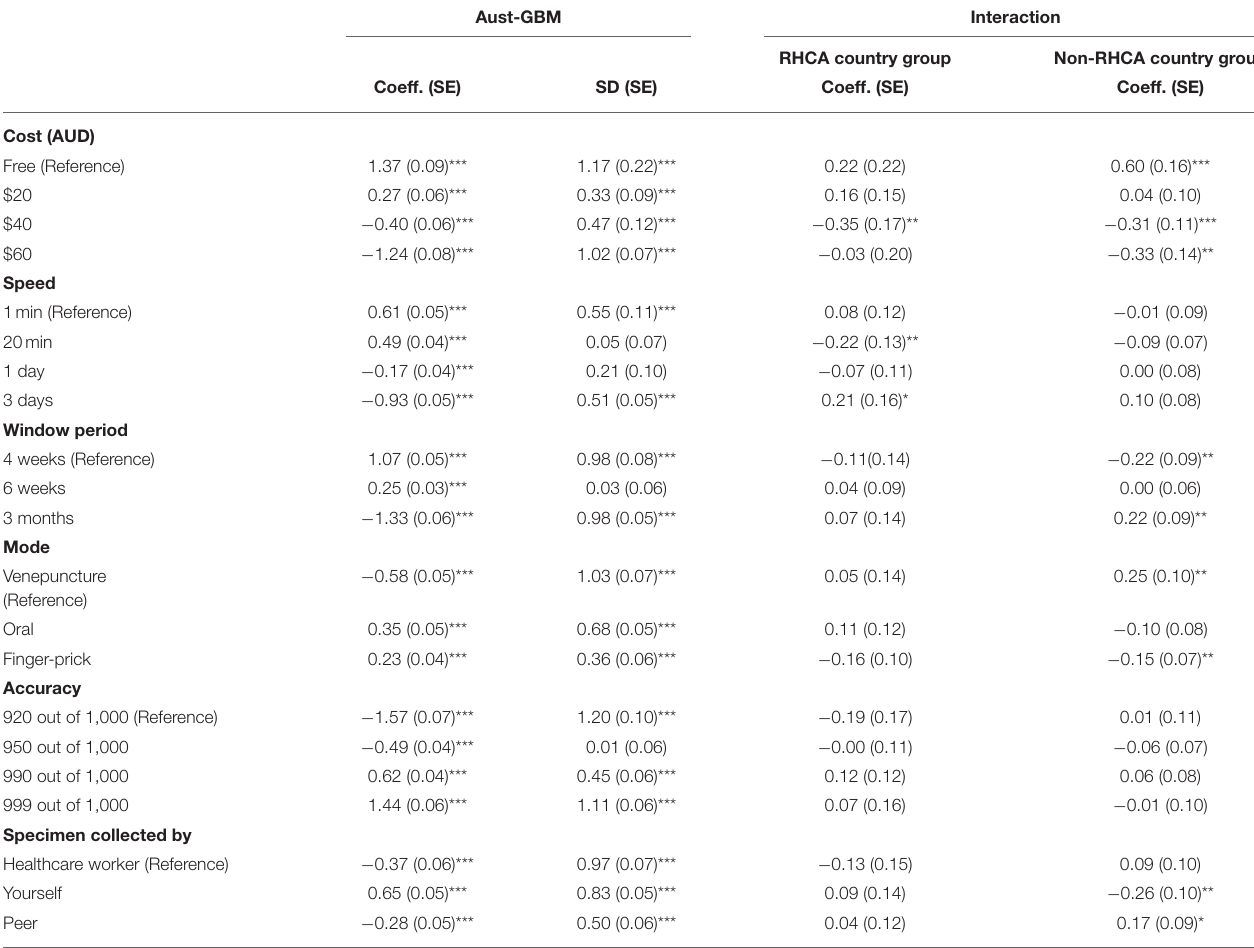
TABLE 2 | Preferences for HIV testing (DCETest) using the mixed logit